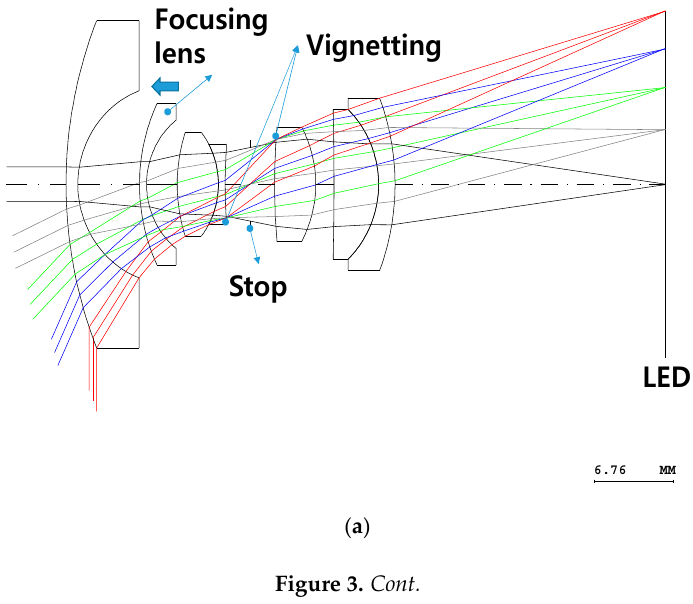
Figure 3. Cont. Figure 3.